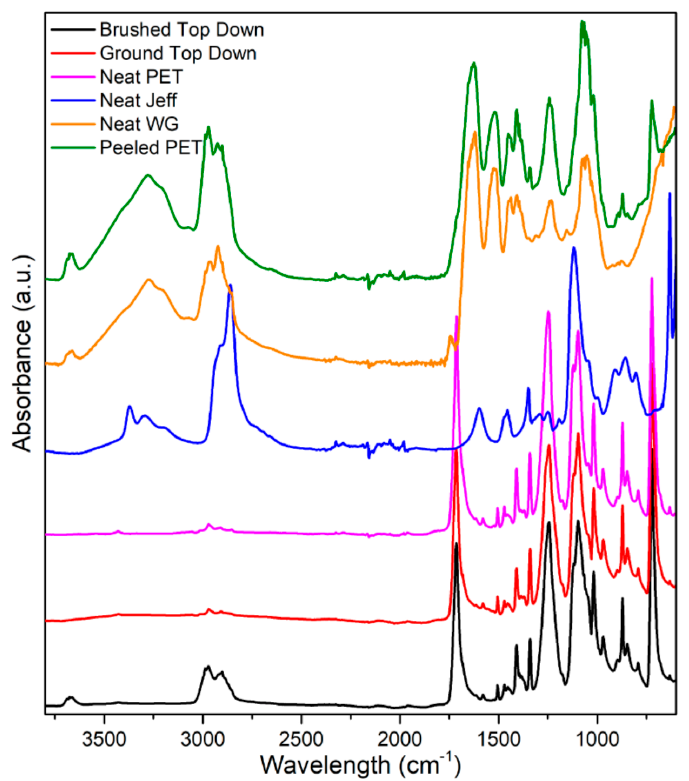
Figure 13. FT-IR spectra of the different neat components and the PET laminated WG.